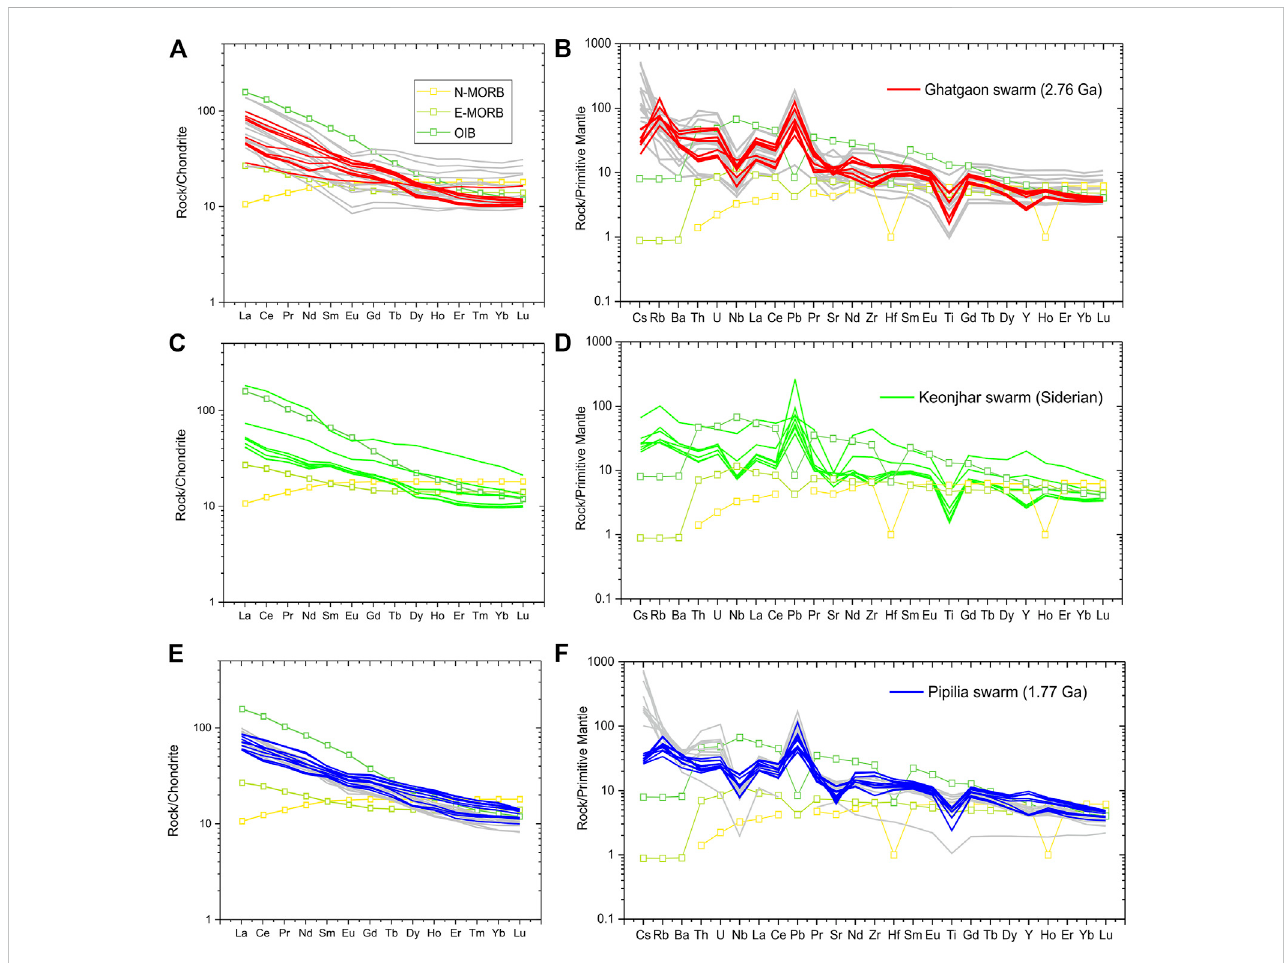
FIGURE 5 Chondrite normalized rare earth element (REE) patterns and primitive mantle normalized multi-element diagram of (A, B) Ghatgaon dyke swarm (C, D) Keonjhar dyke swarm (E, F) Pipilia dyke swarm. Data from the previous studies (grey lines) are also shown for comparison (Adhikari et al., 2021; Pandey et al., 2021).Intheprimitivemantlenormalizeddiagram,theelementsarearrangedwithincreasingincompatibilityinmantlerocksfromrighttoleft.Thenormalizing values of chondrite and primitive mantle are from Sun and McDonough